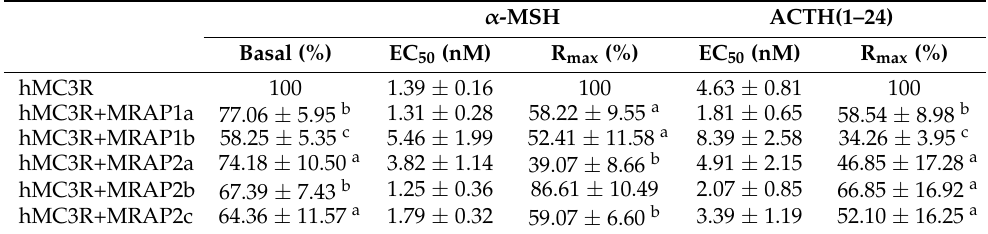
Figure 4. The signaling properties of hMC3R regulated by hMRAP1s or hMRAP2s in response to α -MSH ( A ) and ACTH ( B ). HEK293T cells were transiently transfected with hMC3R with or without hMRAP1a, hMRAP1b, hMRAP2a, hMRAP2b or hMRAP2c plasmids (1:5). Intracellular cAMP levels were measured by RIA after stimulation with different concentrations of α -MSH and ACTH(1–24). The curves are representative of at least three independent experiments. All experiments were performed at least three times independently. Table 2. The signaling properties of hMC3R regulated by hMRAP1s and